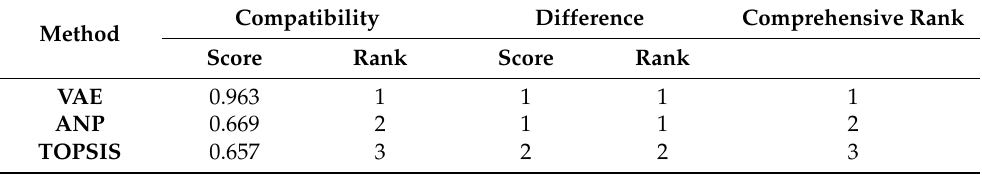
Table 9. Compatibility and difference of three evaluation methods. Compatibility Method